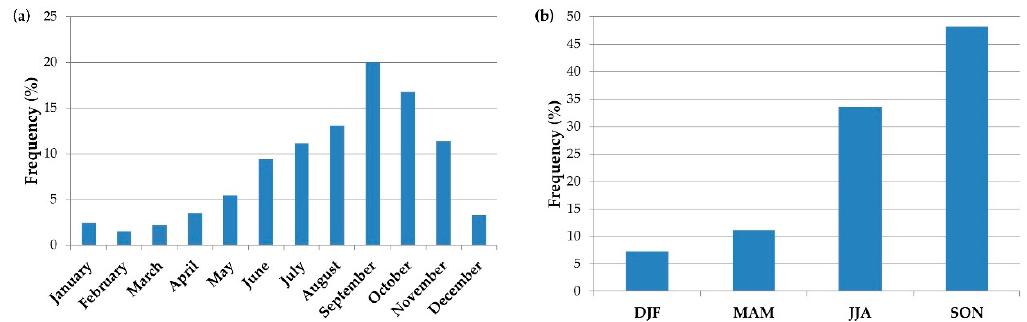
Figure 2. Monthly ( a ) and seasonal ( b ) frequency histograms for the investigated events .